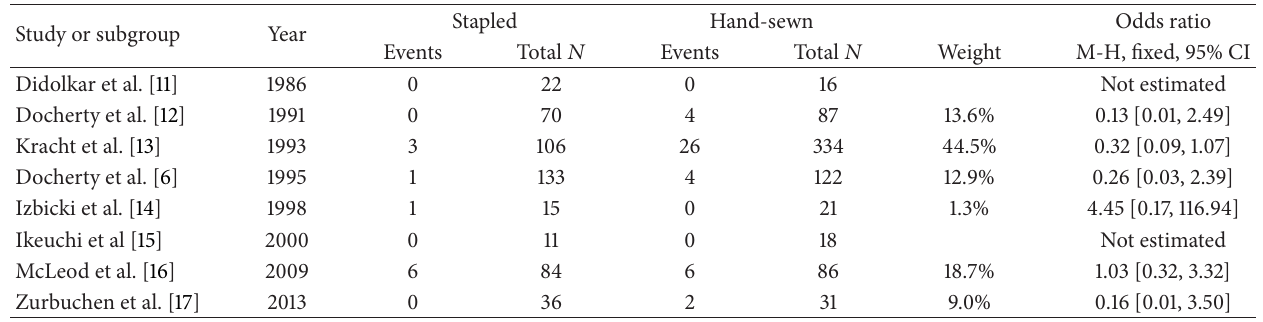
Figure 1: Forrest plot of comparison using data from all studies for anastomotic leak rates. Table 3: Clinical trials included in the meta-analysis.